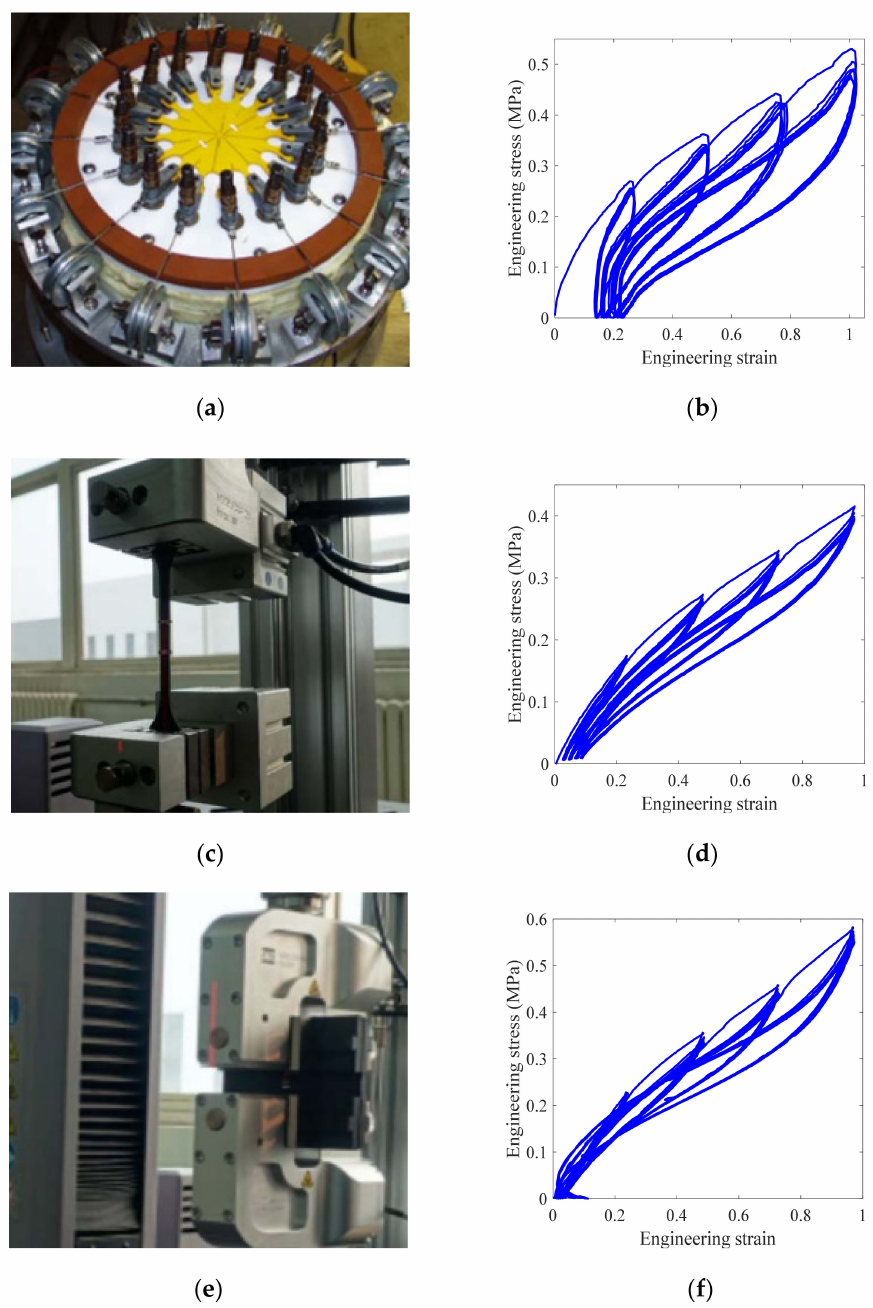
Figure 4. Rubber sample test results: ( a ) Equibiaxial tensile test; ( b ) Equibiaxial tensile stress- strain; ( c ) Uniaxial tensile test; ( d ) Uniaxial tensile stress-strain; ( e ) Plane tensile test; ( f ) Plane tensile